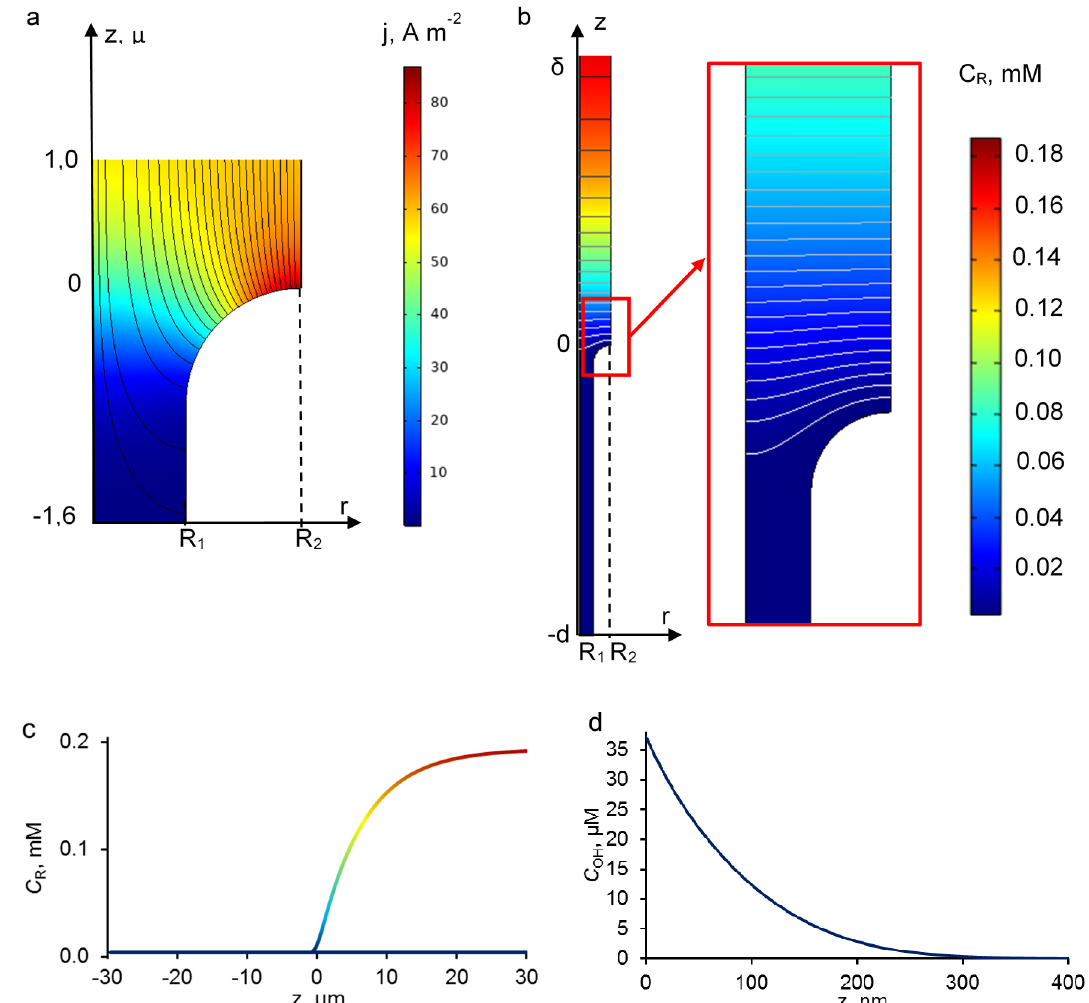
Figure 5. Calculated current density distribution and current lines near the entrance of the pore ( a ). Theoretical concentration distribution of PCT in the system ( b ), at the symmetry axis at r = 0 ( c ). Theoretical concentration distribution of HO • radicals at r = R 2 ( d ). The calculations were performed at j = 60 A · m − 2 ; V = 0.0001 m / s. All other parameters are presented in Table 1. Table 1. Parameters of the system used in the simulations. PCT: paracetamol.